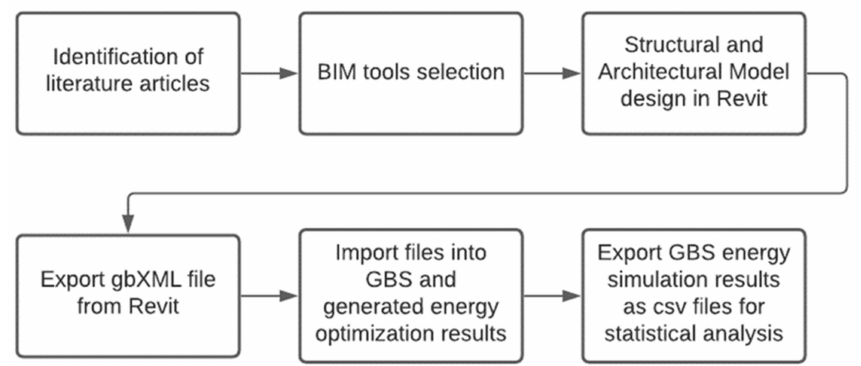
Figure 5. Green Building Studio modeling